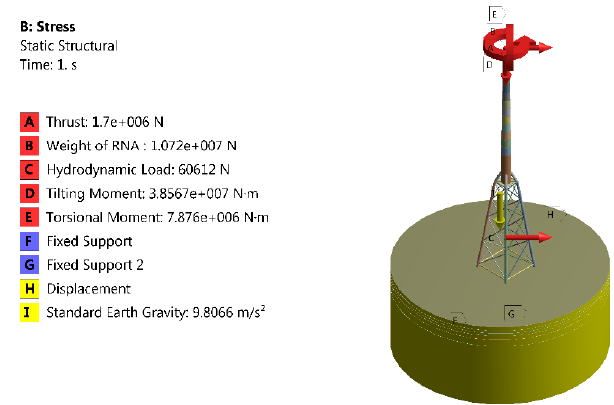
Figure 5. The 3D display of structural model with applied loads and boundary conditions.